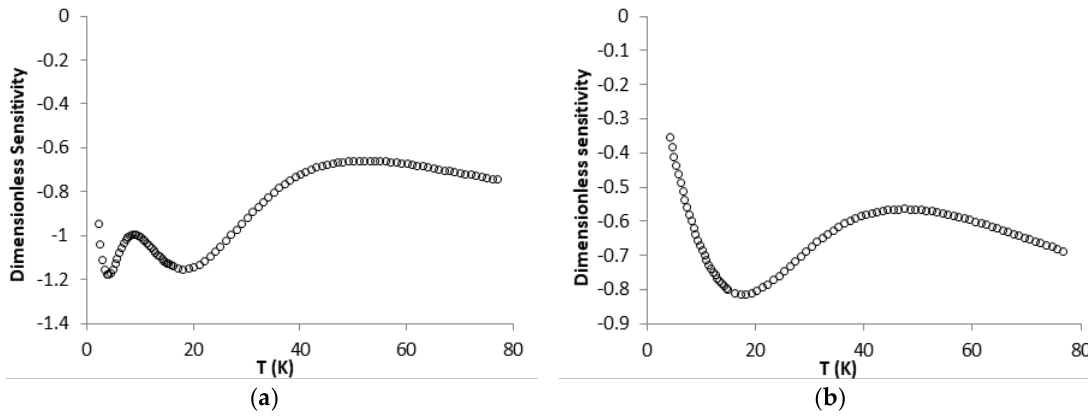
Figure 7. Specific sensitivity for: Sensor 1 ( a ); and Sensor 2 ( b ).